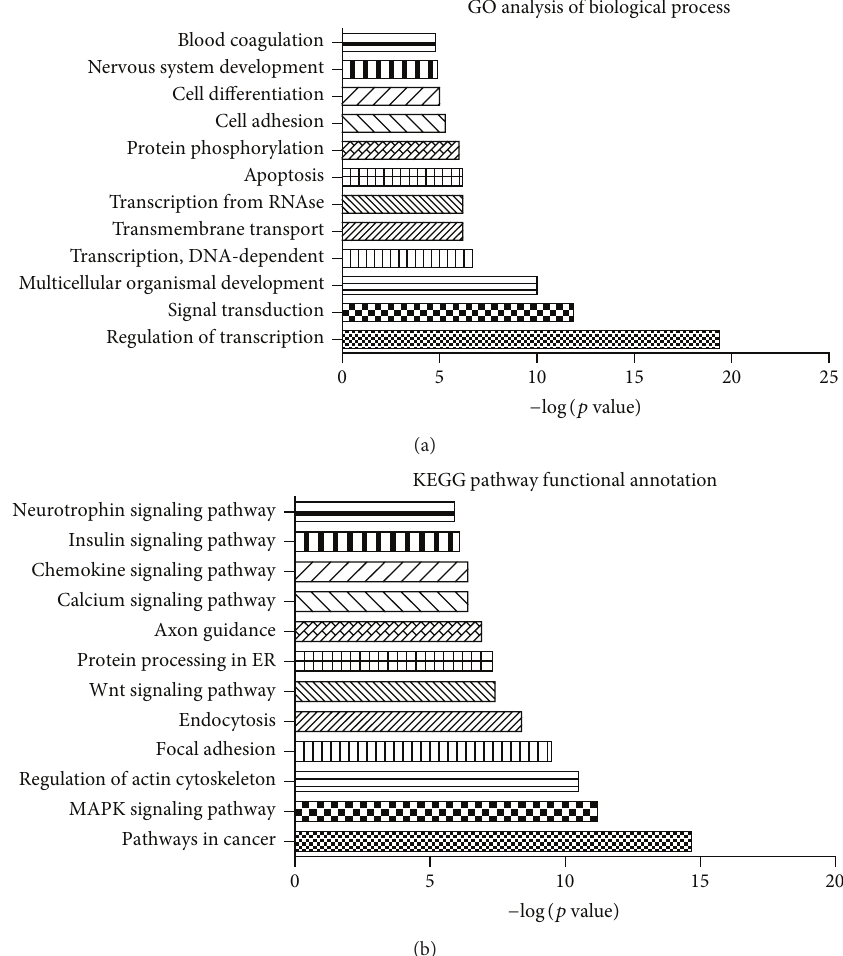
Figure 4: Functional annotation analysis of 3 miRNAs. GO analysis of biological process (a) and KEGG pathway functional annotation (b) of the differentially expressed miRNA (AUC values ≥ 0.90) predicted targets. Enrichment scores corresponding to each catalogue provided by the DAVID annotation tool are displayed as − log 𝑝